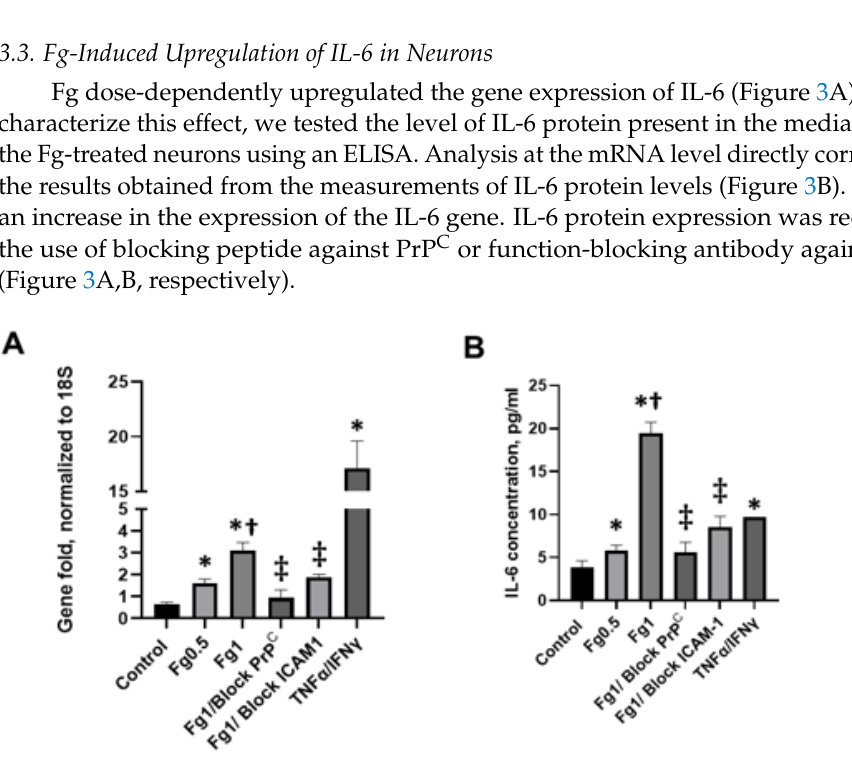
Figure 3. The fibrinogen (Fg)-induced increase in expression of interleukin 6 (IL-6) in neurons. The cells were treated with medium alone (control), 0.5 mg/mL, 1 mg/mL of Fg, 1 mg/mL of Fg in the presence of a cellular prion protein (PrP C )-blocking peptide (Fg1/block PrP C ), or 1 mg/mL of Fg in the presence of a function-blocking antibody against intercellular adhesion molecule-1 (ICAM-1) (Fg1/block ICAM-1) for 24 h. The experimental group treated with tumor necrosis factor alpha (TNF α ) co-stimulated with interferon gamma (IFN γ ) was used as a positive control. The treated cells were kept for 24 h in 5% CO 2 at 37 ◦ C. Hirudin was present in all experimental groups to prevent the conversion of Fg to fibrin. ( A ) IL-6 mRNA expression analyzed by quantitative real-time PCR (qRT-PCR). The relative expression of cytokine RNA was normalized to the 18S housekeeping gene. ( B ) The level of IL-6 protein was measured in the medium from neurons using an enzyme-linked immunosorbent assay (ELISA). p < 0.05 in all; ∗ —vs. Control, †—vs. Fg0.5, ‡—vs. Fg1; n =